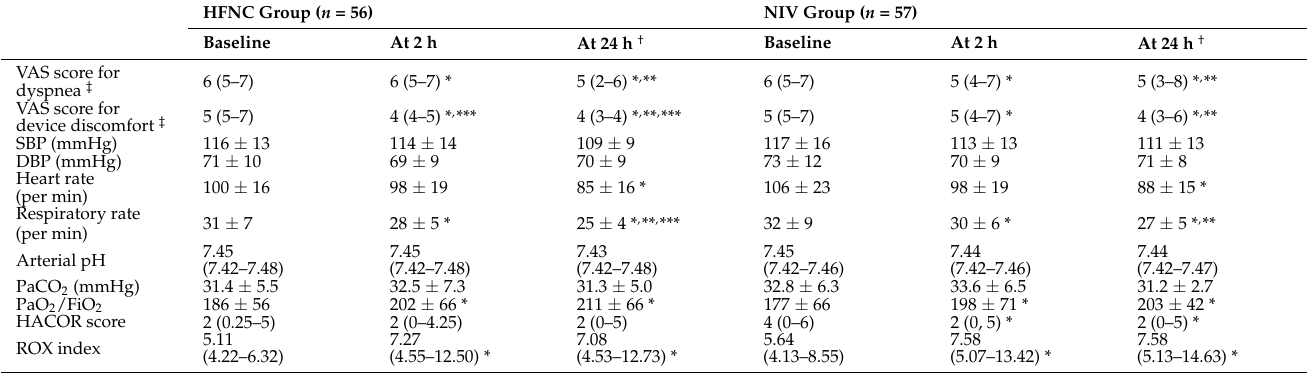
Table 2. VAS scores, vital signs, and arterial blood gas analyses of enrolled AIDS patients.